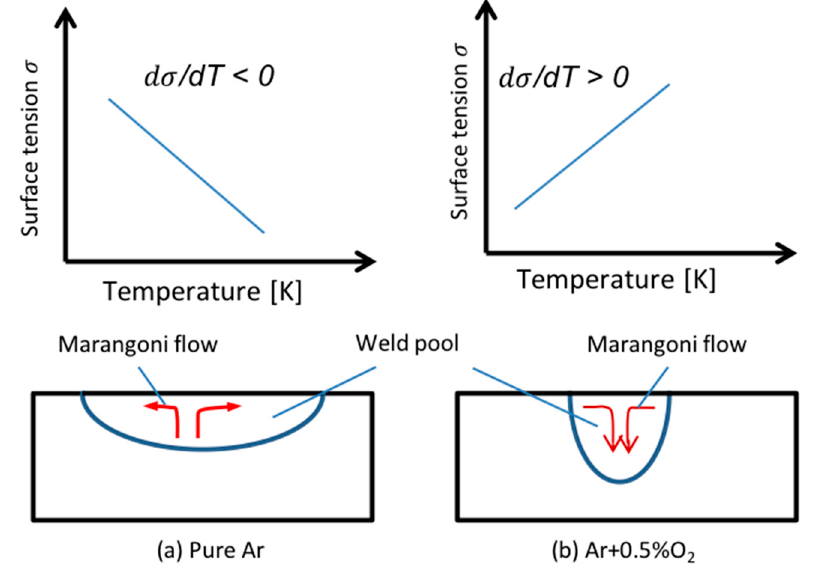
Figure 14. Schematic illustration of Marangoni force on the weld pool surface redrawn from [27]. ( a ) Pure Ar, ( b ) Ar + 0.5%O 2 .